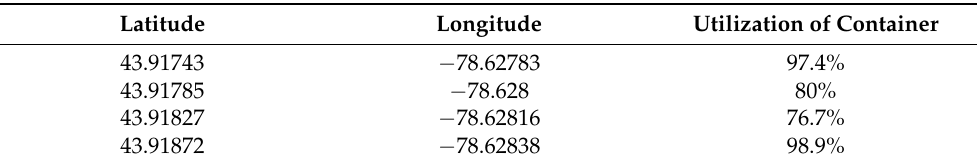
Table 9. None of the containers have 100% utilization due to the maximum distance restriction, however they’re still fairly highly utilized, thus no containers are wasted and the farmer may find this to be a favorable balance between even spacing of containers and properly utilizing the container